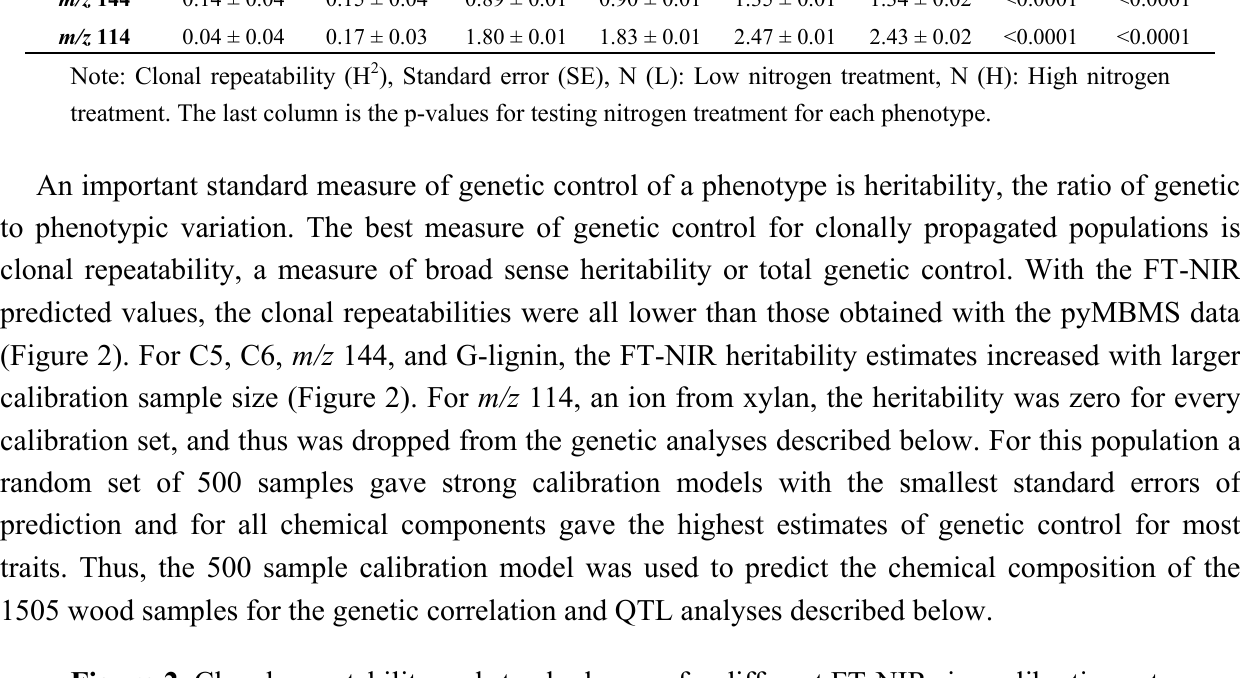
Figure 2. Clonal repeatability and standard errors for different FT-NIR size calibration sets compared with pyMBMS; Error bars correspond to standard errors of the